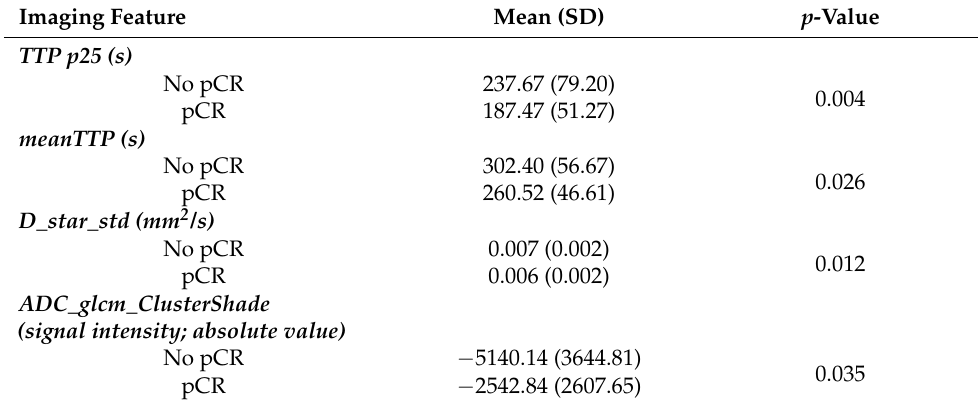
Table 3. Results of the imaging feature analysis according to the presence or absence of patho- logical complete response. Only statistically significant results are presented ( p < 0.05). “ADC” prefix in ADC_glcm_ClusterShade indicates the type of sequence (diffusion) that textural feature was extracted